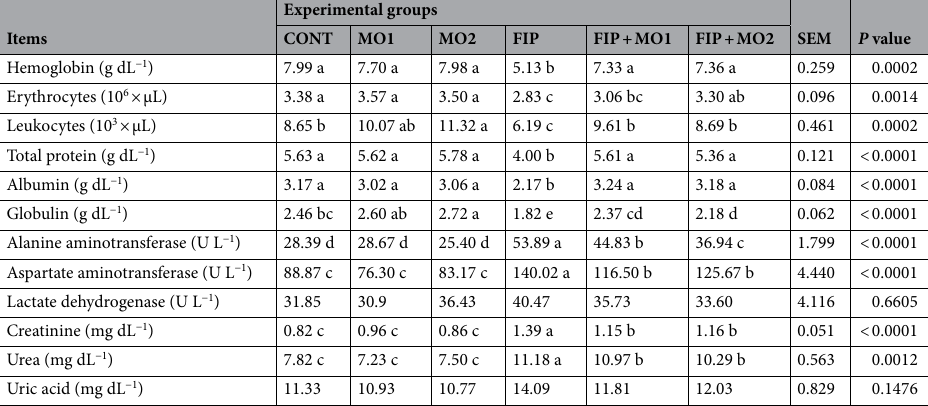
Table 4. Haemato-biochemical measurements of Nile tilapia groups during the present study. Data represent means ± S.E.M and means having different letters in the same row are significantly different at P < 0.05.